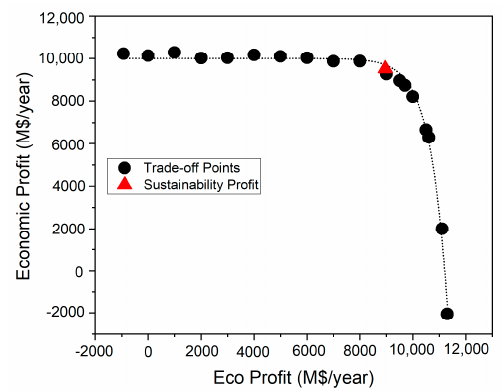
Figure 2. Trade-o ff between eco and economic profits. Figure 2. Trade-off between eco and economic profits.